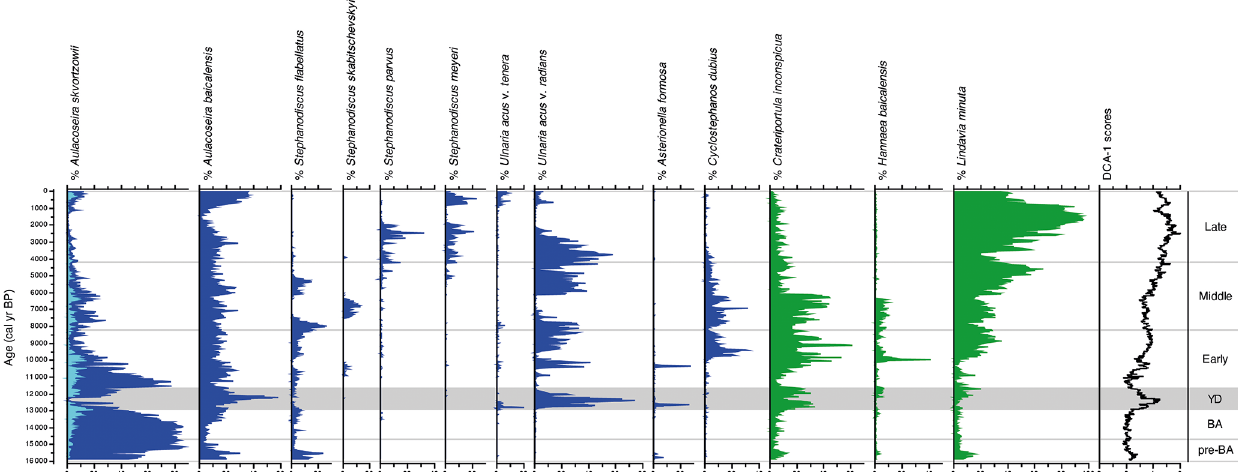
Figure 3. Relative abundances of sub-fossil planktonic and tychoplanktonic diatoms spanning the past ca. 16kyr from Vydrino Shoulder. Diatoms which grow mainly before summer stratification are shown in blue, while those that mainly grow after summer stratification are shown in green. DCA axis 1 sample scores summarize the major trend in species turnover. Table 1. GAMs to investigate PDR trends during pre-defined climate periods. edf = effective degrees of freedom, and ref.df = reference degrees of freedom. The goodness-of-fit statistics show the adjusted r 2 = 0 . 462, and the deviance explained is 53.2%. Climate period edf ref.df F statistic p value Late Holocene 3.719 4.481 Middle Holocene 1.001 Early